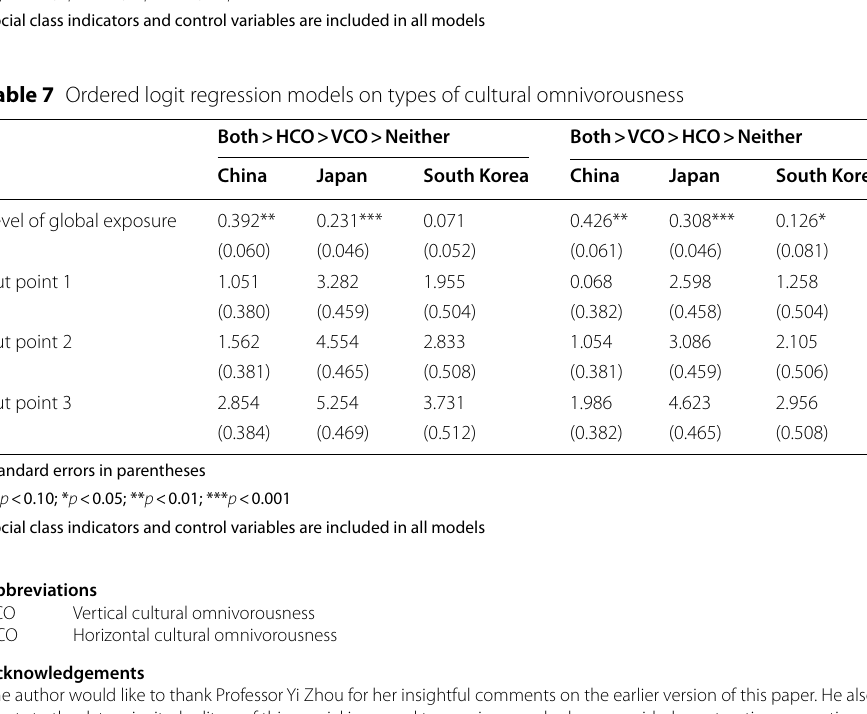
Standard errors in parentheses Social class indicators and control variables are included in all models Table 7 Ordered logit regression models on types of cultural omnivorousness